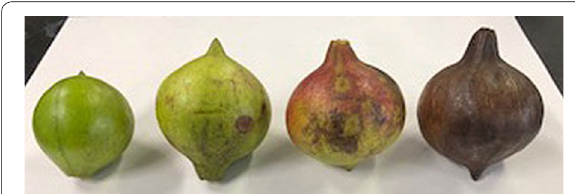
Fig. 1 The developmental stages of tung tree fruits. From left, stage 1 (immature green): green fruits about 4.5 cm in diameter, 4 months after anthesis. Stage 2 (mature green): green fruits about 6 cm in diameter, 5 months after anthesis. Stage 3 (turning): red brown fruits about 6 cm in diameter, 5 months after anthesis. Stage 4 (over ripe): brown fruit about 6 cm in diameter, 5 months after anthesis Fig. 2 The seed, seed coat, and endosperm of the tung tree from